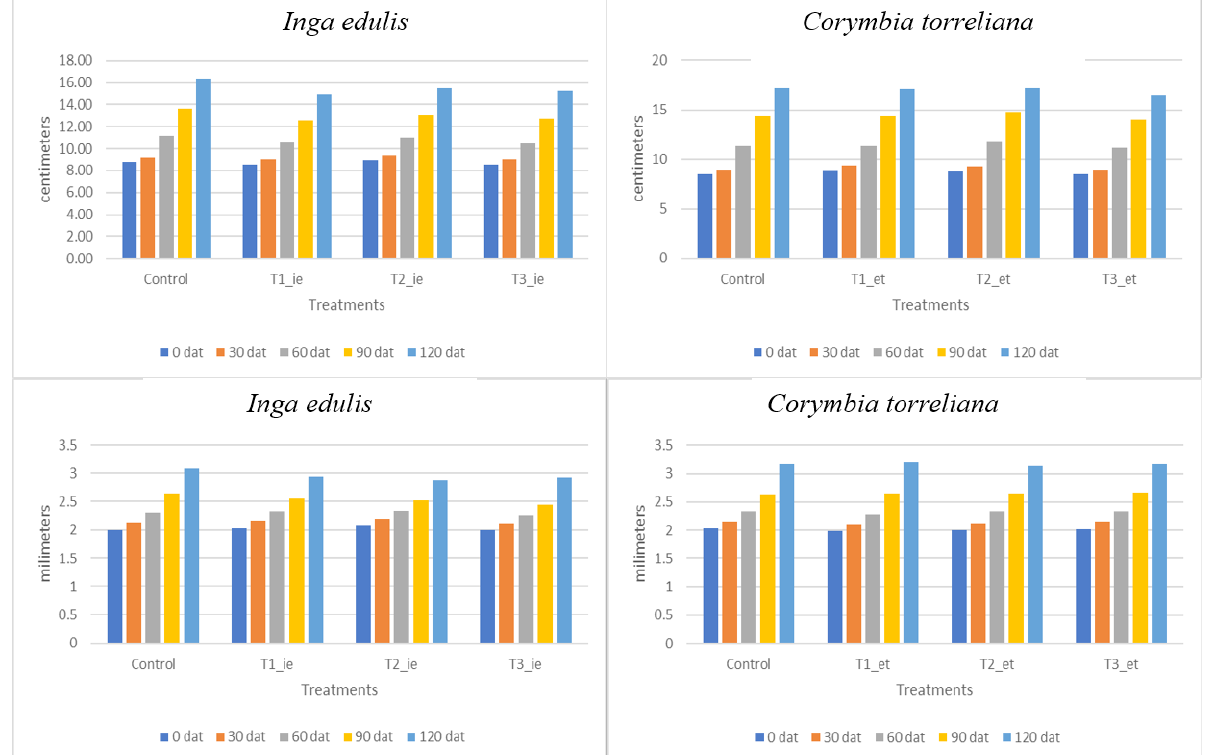
Figure 1. Heights (cm) and diameters (mm) of coffee (Coffea arabica ‘Caturra Roja’) plants treated with foliar extracts of guaba (Inga edulis) and cadaghi (Corymbia torrelliana) under nursery conditions in Chanchamayo, Peru. dat, days after transplant. See Table 2 for a description of the treatments.